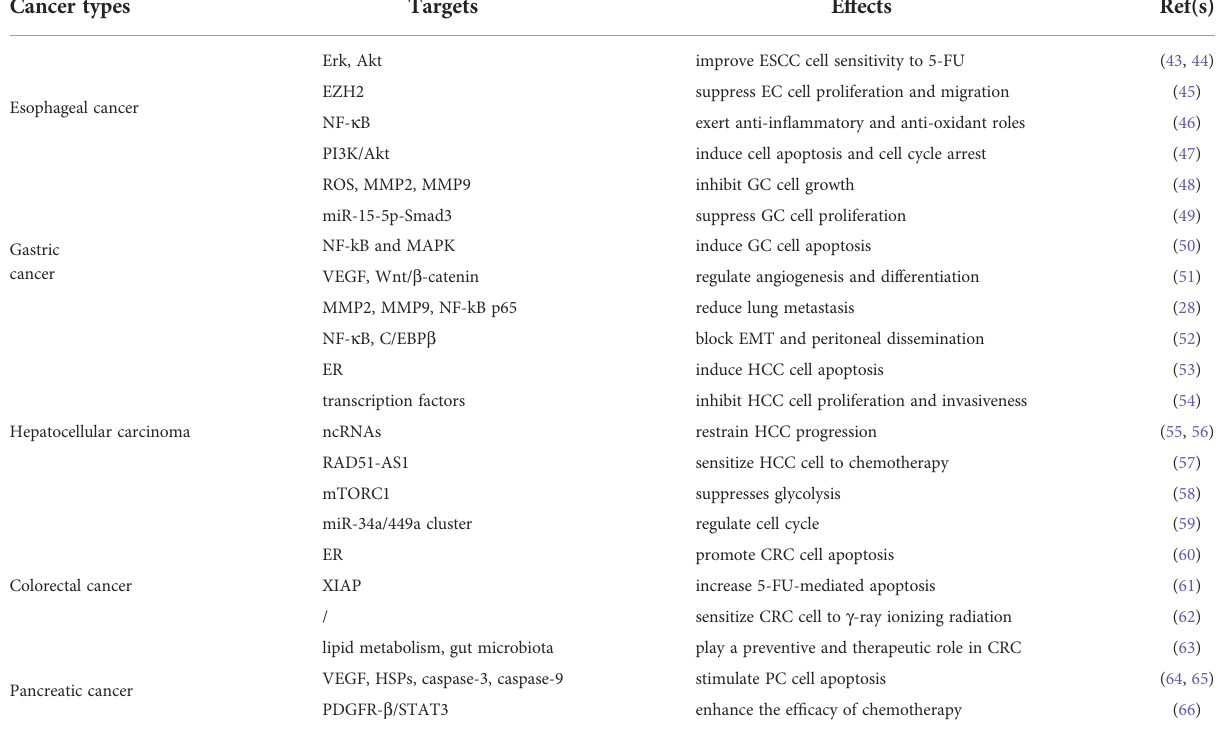
TABLE 1 Effects of melatonin against various gastrointestinal